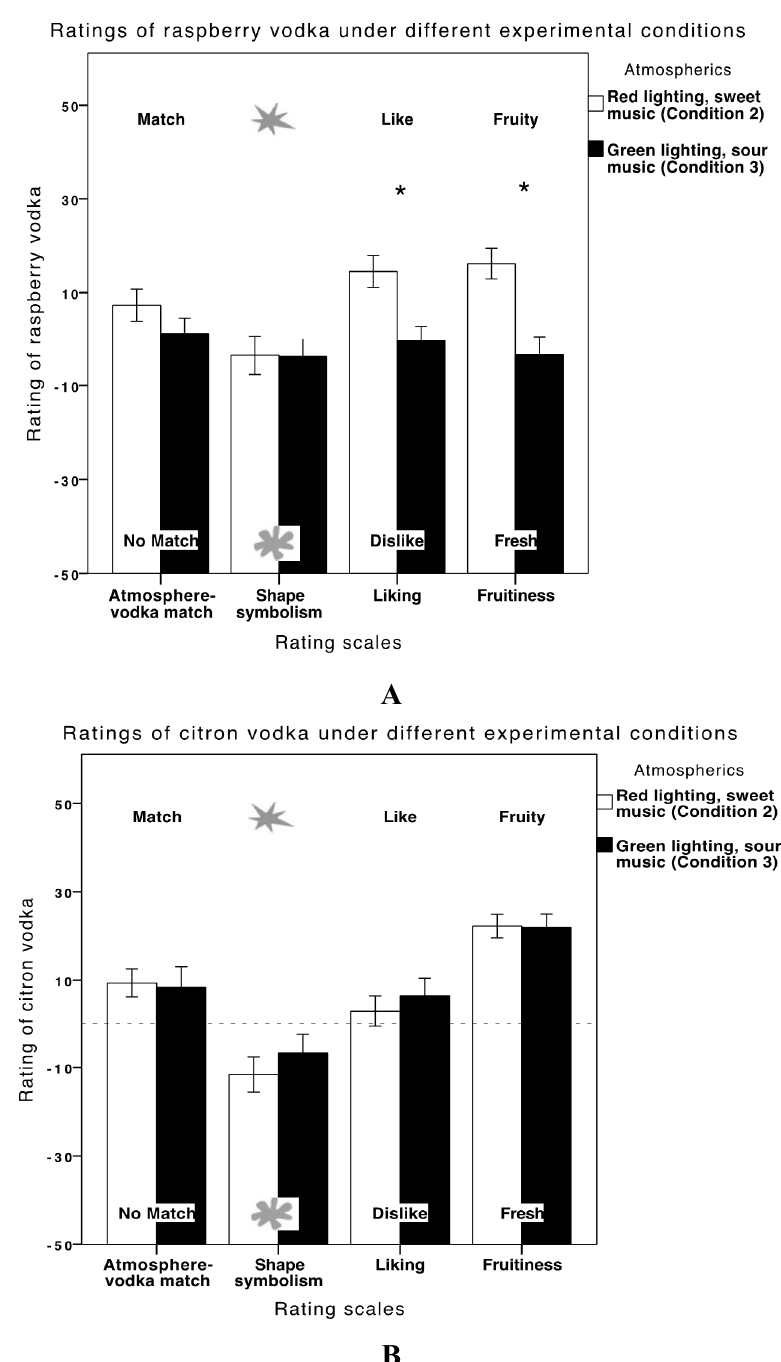
Figure 3. Participants’ ratings of the raspberry ( A ) and citron ( B ) vodka under the different experimental conditions. In Condition 2, the ambient lighting was red and putatively sweet music was played, whereas in Condition 3, the ambient lighting was green and sour music was played (see Knoeferle et al. , 2015 [9]). Each scale was 100 mm long, with the 0 point corresponding to the midpoint of the scale, shown by the dashed line in the figure. The y -axis reflects the distance of participants’ responses from the midpoint, from − 50 mm to 50 mm. The asterisks highlight a significant difference between the conditions ( p < 0.05). The error bars represent the standard error of the